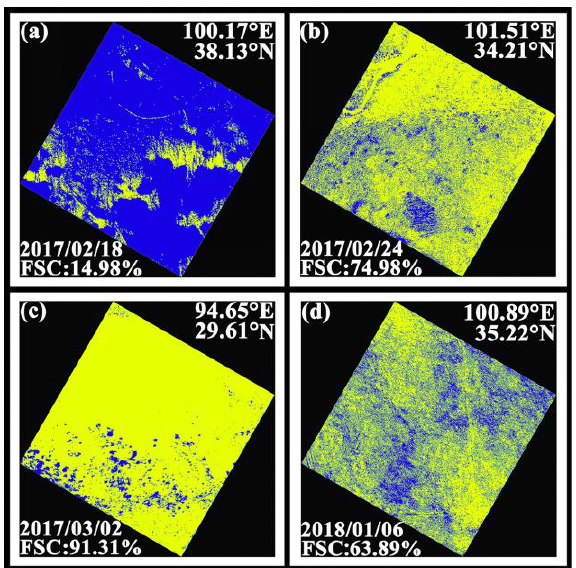
Figure 3. Fractional snow cover (FSC) retrieved from UAV images based on supervised classification. Yellow represents snow-covered areas and blue represents snow-free areas. Each image covers a range of 500 × 500 m. Data acquisition date: ( a ) Feb. 18, 2017; ( b ) Feb. 24, 2017; ( c ) March 2, 2017; ( d ) Jan. 6, 2018. Table 2. Significance test between each influencing parameter and the